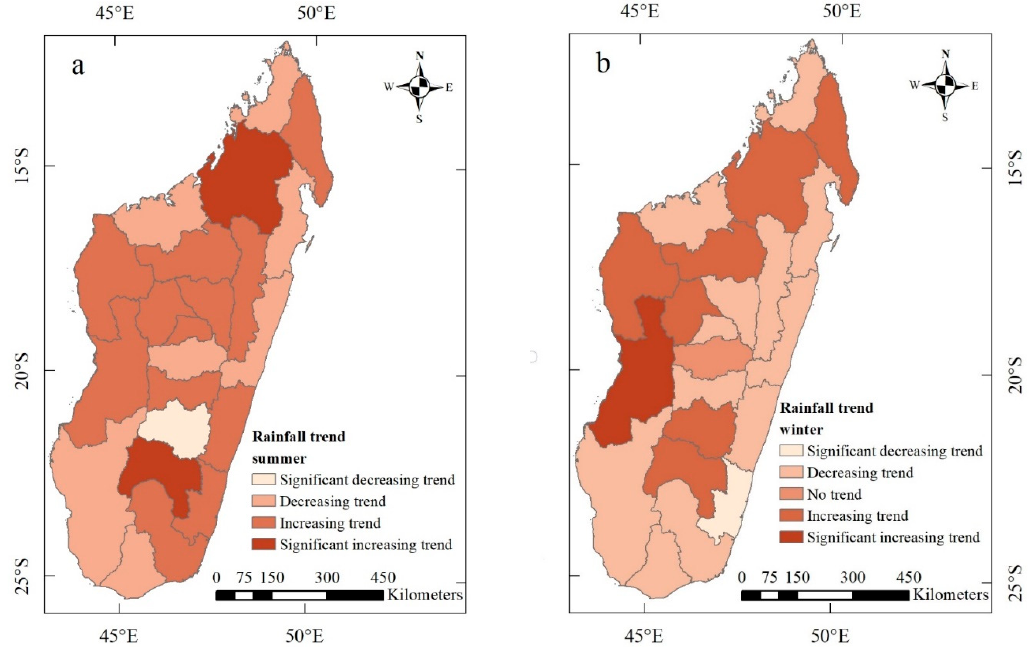
Figure 8. ( a ) Summer and ( b ) winter rainfall trend for each region in Madagascar.